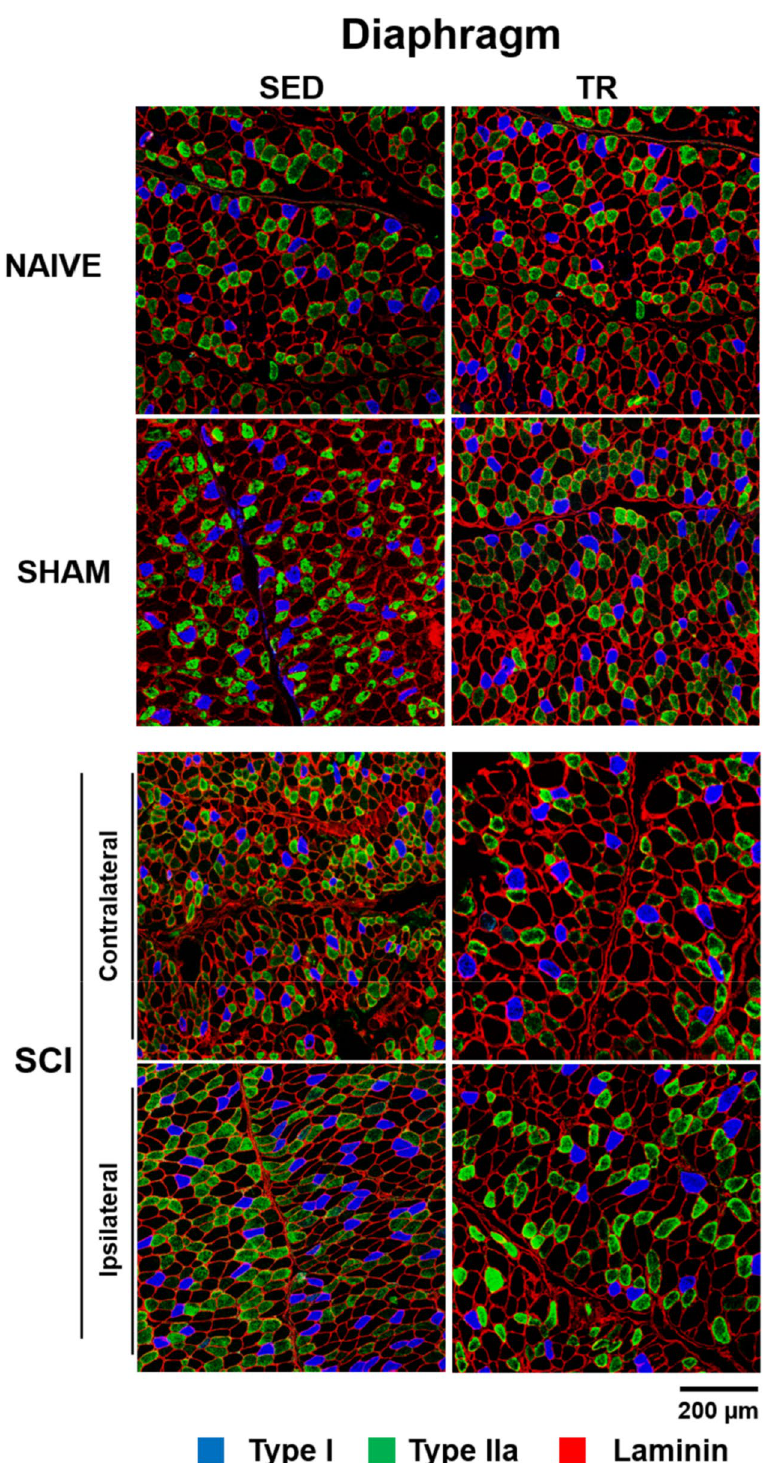
Figure 7. Representative images of fiber type composition in respiratory muscle. Diaphragmatic muscle cryosections were immunostained to visualize Myosin heavy chain (MyHC) isoforms: MyHCSlow (type I in blue), MyHC2A (type IIa in green) co-labeled with an anti-laminin antibody to visualize myofiber boundaries (type IIb/x corresponding to unlabeled fibers). Scale bar = 200